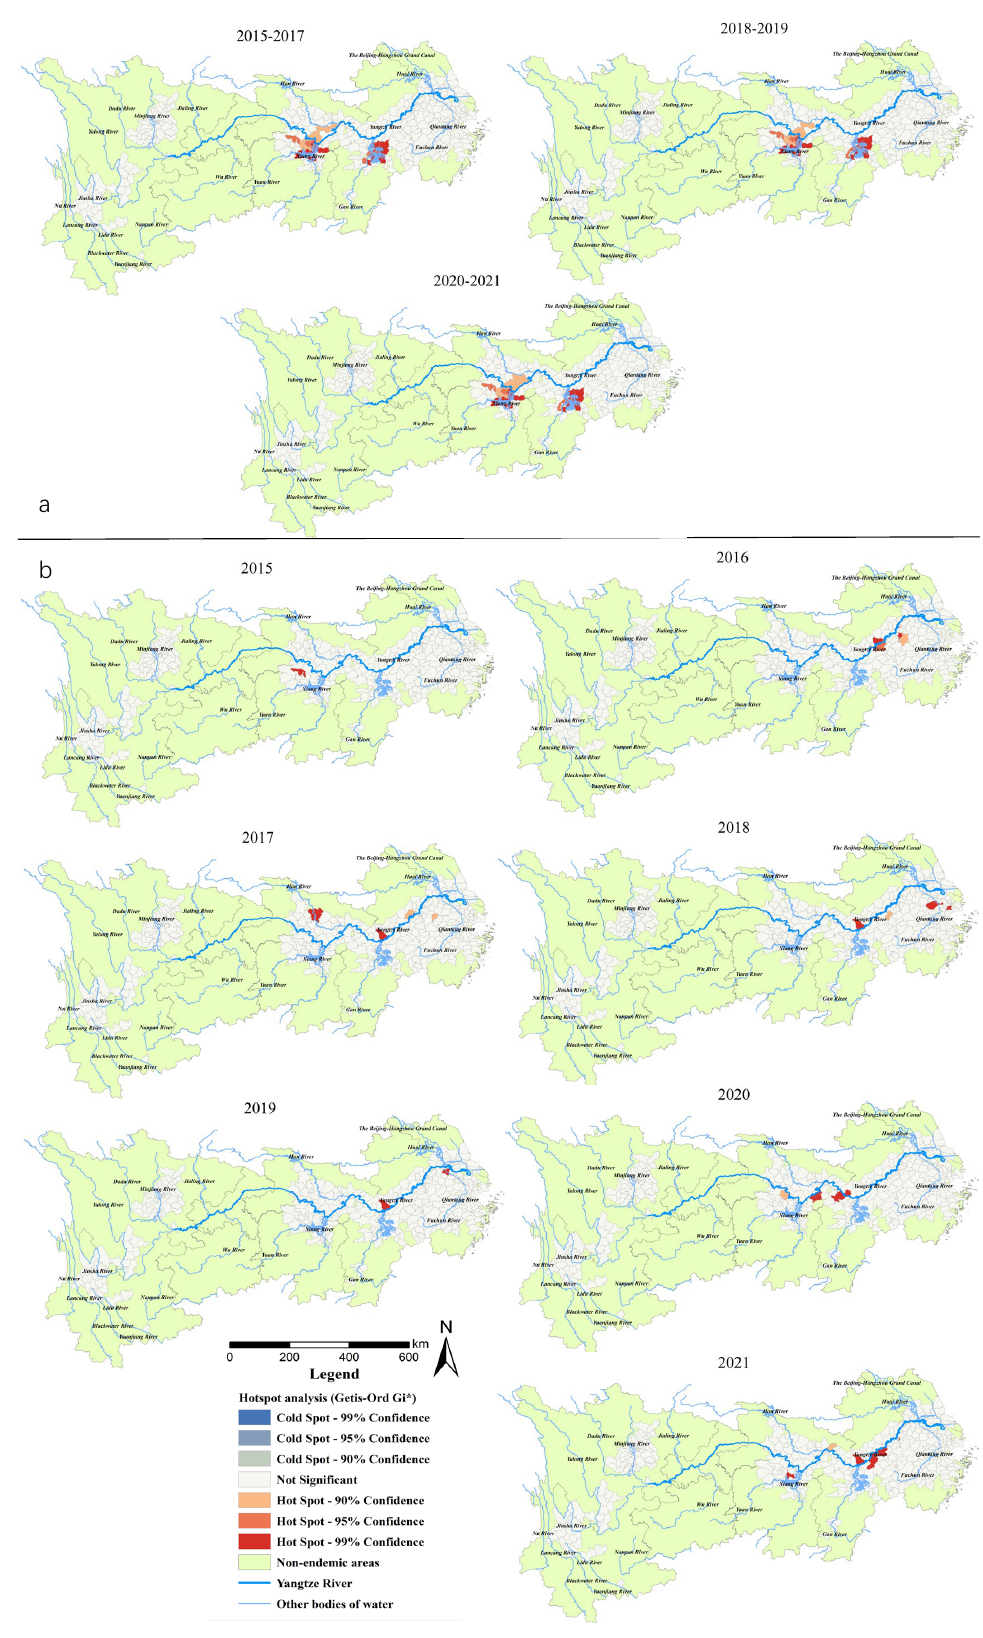
Figure 4. ( a ) Total area of the snail habitats; ( b ) emerging snail habitats. Hotspot areas of snail habitats in the endemic areas in the YEB,